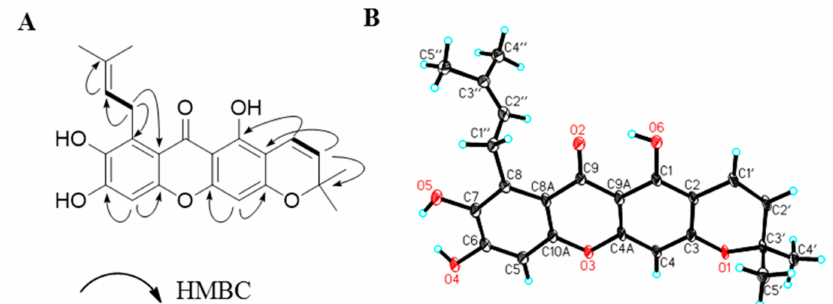
Figure 2. Identification of chemical structure of compound 1 from G. mangostana . ( A ) Selected heteronuclear multiple bond correlation (HMBC) correlations (H → C) of 1 and ( B ) X-ray crystallographic analysis of 1